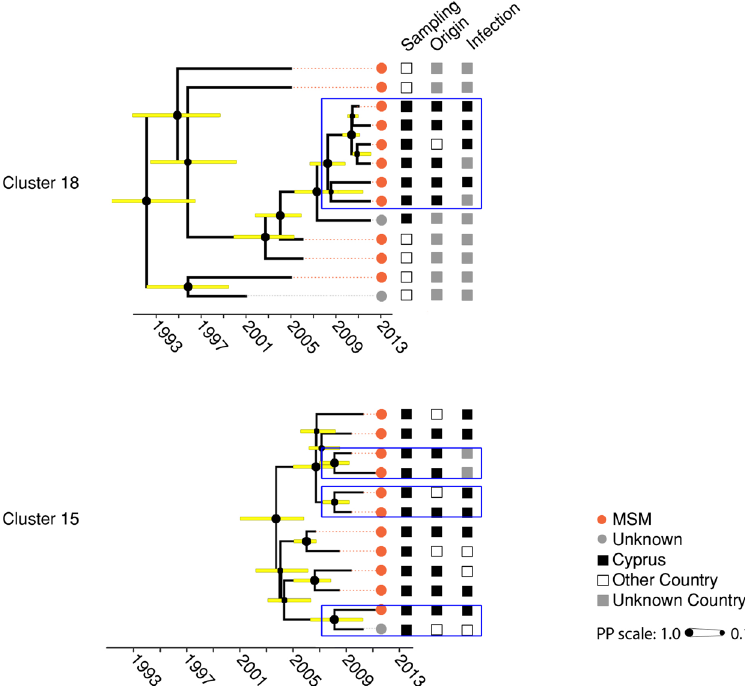
Figure 5. Subtype B MSM transmission clusters (TCs). The two largest subtype B TCs (#15 and #18, respectively) with mainly Cypriots who reported being MSM are illustrated with additional demographic information. The upper TC (#18) originated in 1992 [Bayesian Credible Interval (BCI): 1987–1996], while the lower TC originated in 2003 [2004–2006]. Horizontal bars indicate the BCI of each node. The dashed gray line indicates the past five years or the cluster depth. The colored circles at the tips of the tree show the risk group and squares represent the country of sampling, the country of origin and the country of infection, respectively. Active clusters within the TCs are outlined in dark blue